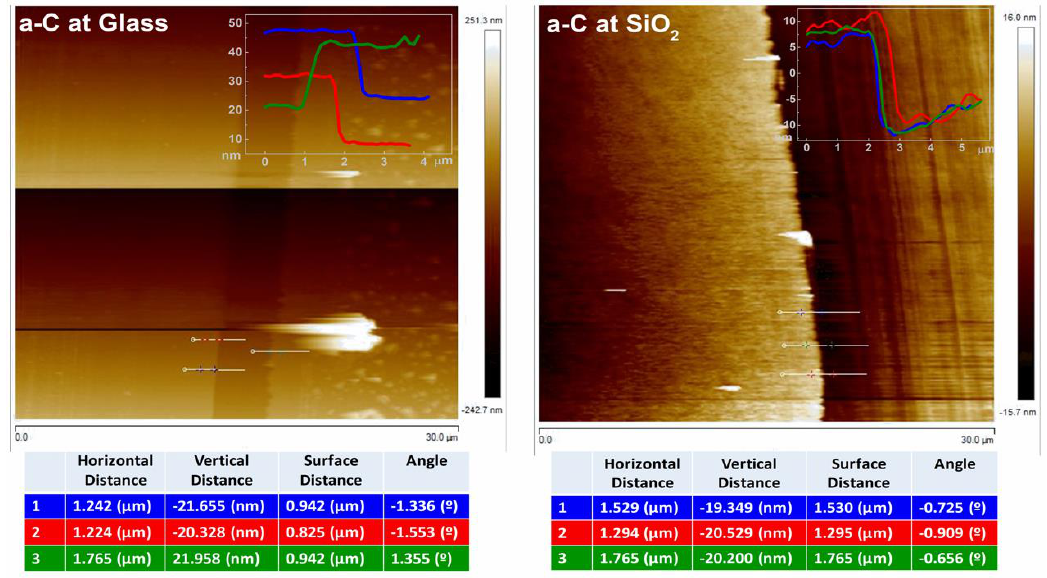
Figure 3. AFM surface morphology spectra and thickness plots for a-Carbon on glass and SiO 2 substrates.